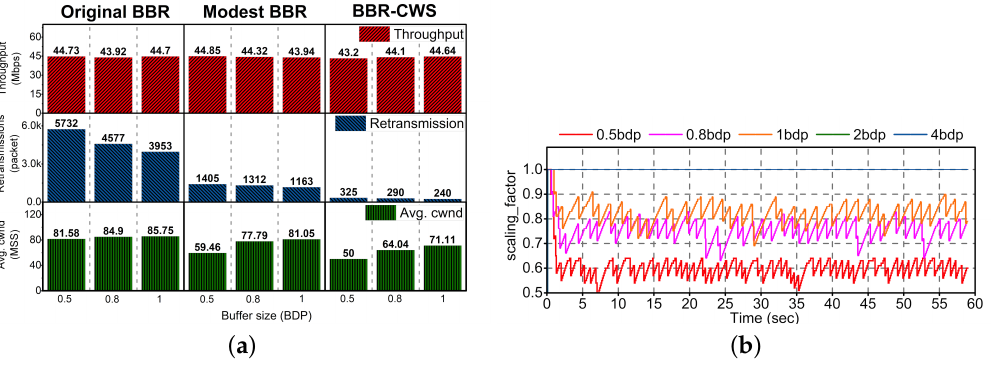
Figure 8. Single BBR-CWS operations: ( a ) Throughput, loss and average cwnd of BBR: ; and ( b ) upper_scaling_factor of BBR-CWS.